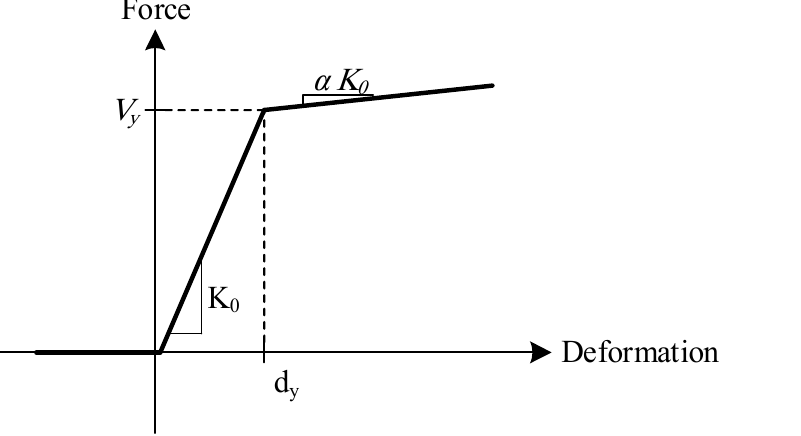
Figure 7. Bi-linear model for the strips. Table 3. Bi-linear axial hinge